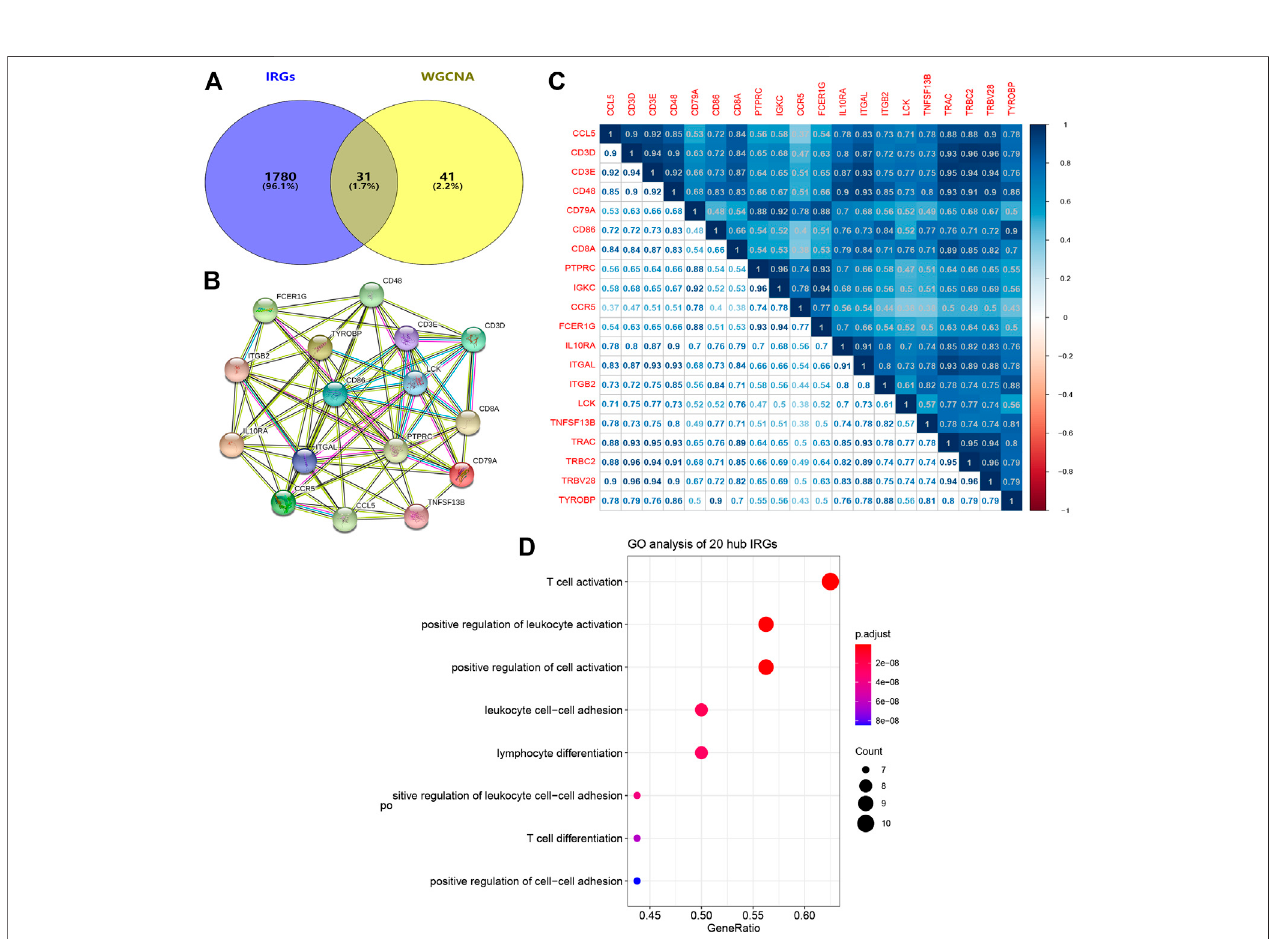
FIGURE 6 | PPI network and biological process analyses of hub IRGs related to prognosis. (A) The common genes between modules genes and IRGs from ImmPortdatabase. (B) PPInetworkof20hubIRGs. (C) Correlationanalysisof20hubIRGs. (D) Biologicalprocessanalysisof20hubIRGs.PPInetwork,protein-protein interaction network; IRGs, immune-related